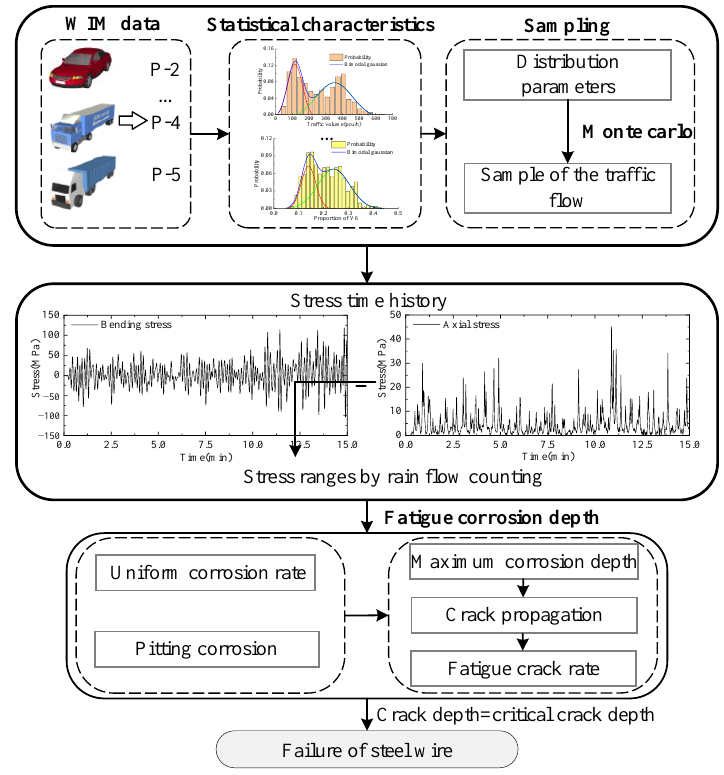
Figure 11. Simulation process of wire life.